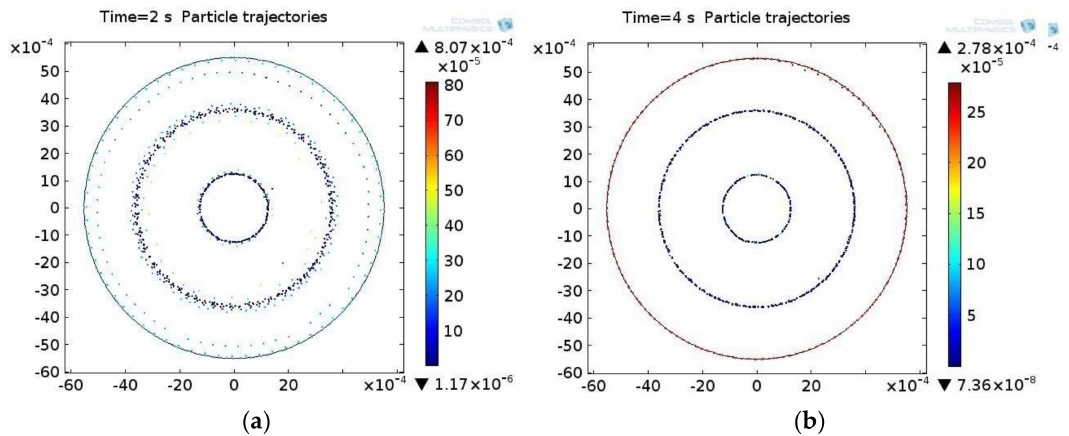
Figure 5. The distribution of particles in the acoustic pressure field in the water suspension at different times t i : ( a ) 2 s, ( b ) 4